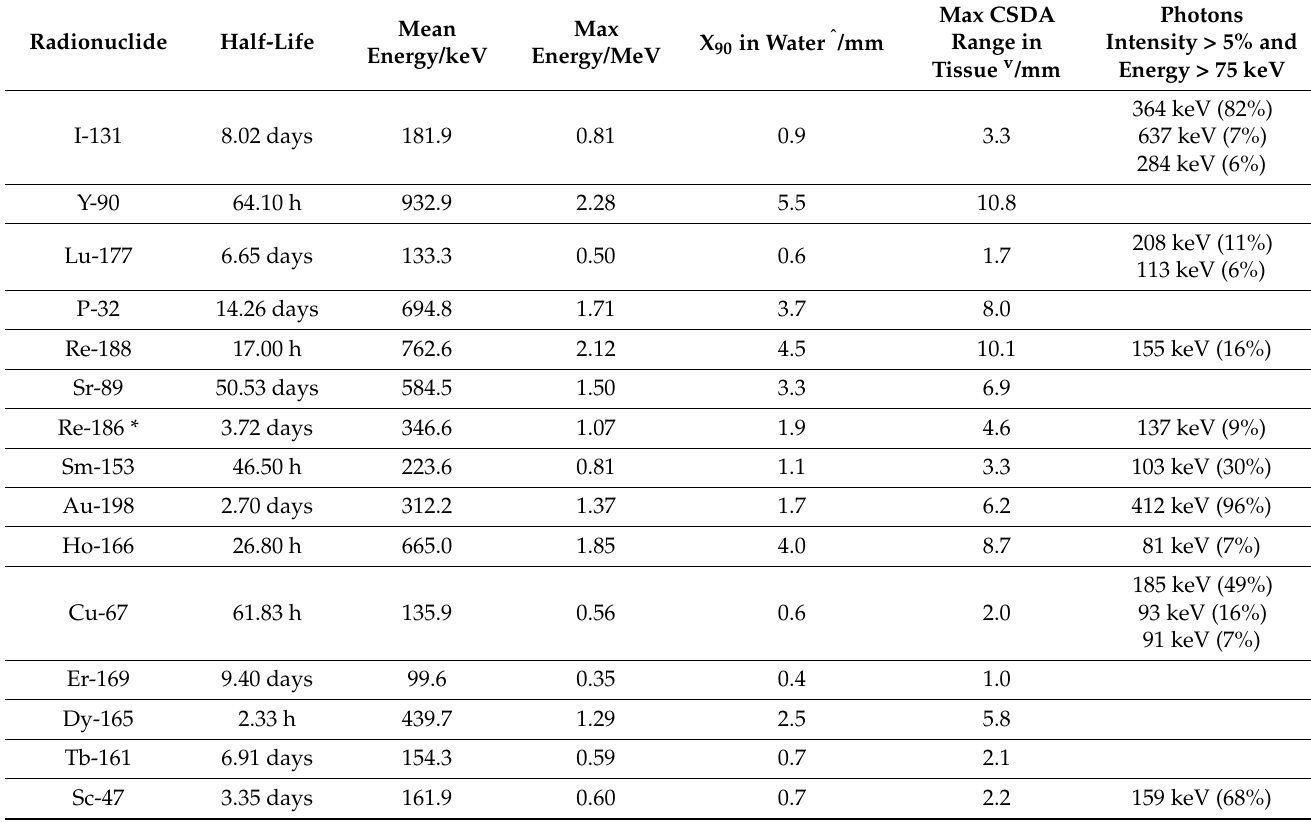
Table 2. According to our search, the 15 beta-emitters most frequently published on in relation to radionuclide therapy and their properties. The data are taken from ICRP 107